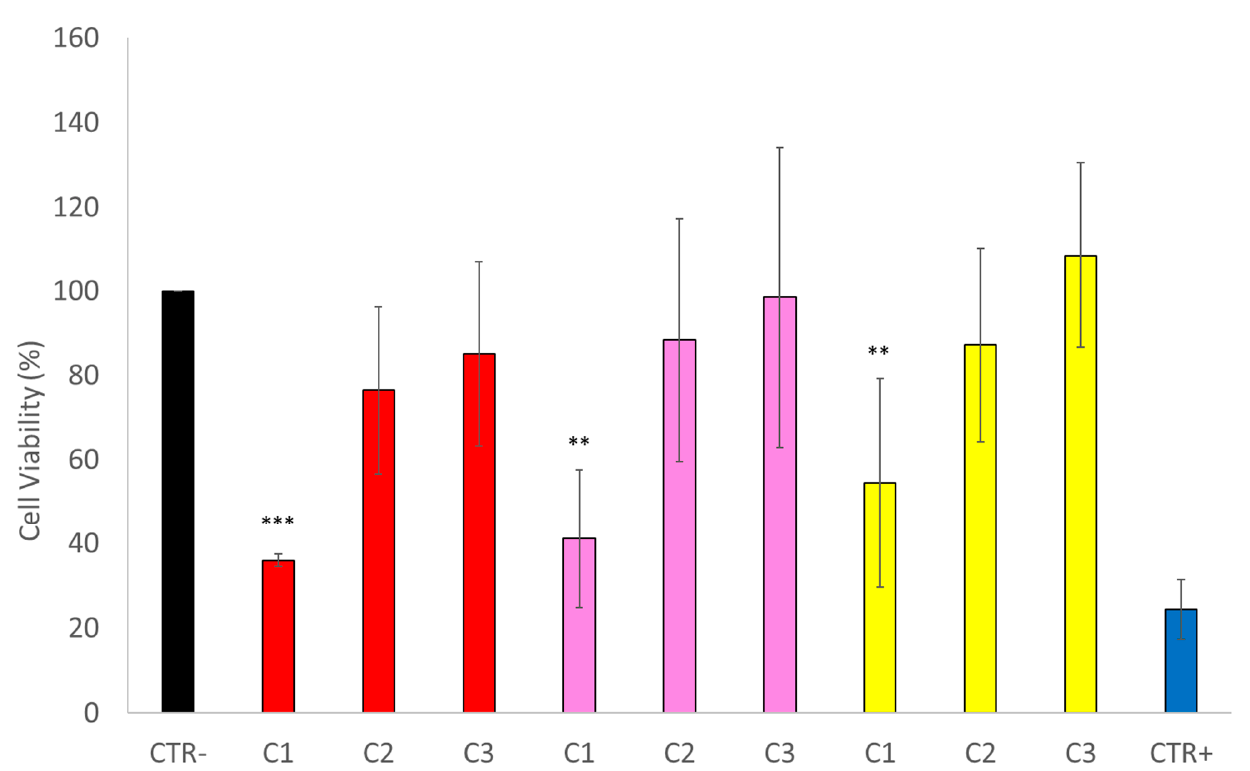
Figure 7. In vitro cytotoxicity results in human osteosarcoma SaOS-2 cells exposed to different nanosystems, using three different activities (C1: 37 kBq, C2: 18.5 kBq, and C3: 4.44 kBq) for each of the following formulations: [ 223 Ra]RaCl 2 +[ 198 Au]AuNPs nanomicelles (in red), [ 223 Ra]RaCl 2 nanomicelles (in pink), and [ 223 Ra]RaCl 2 (in yellow). ** p < 0.01, *** p < 0.005.